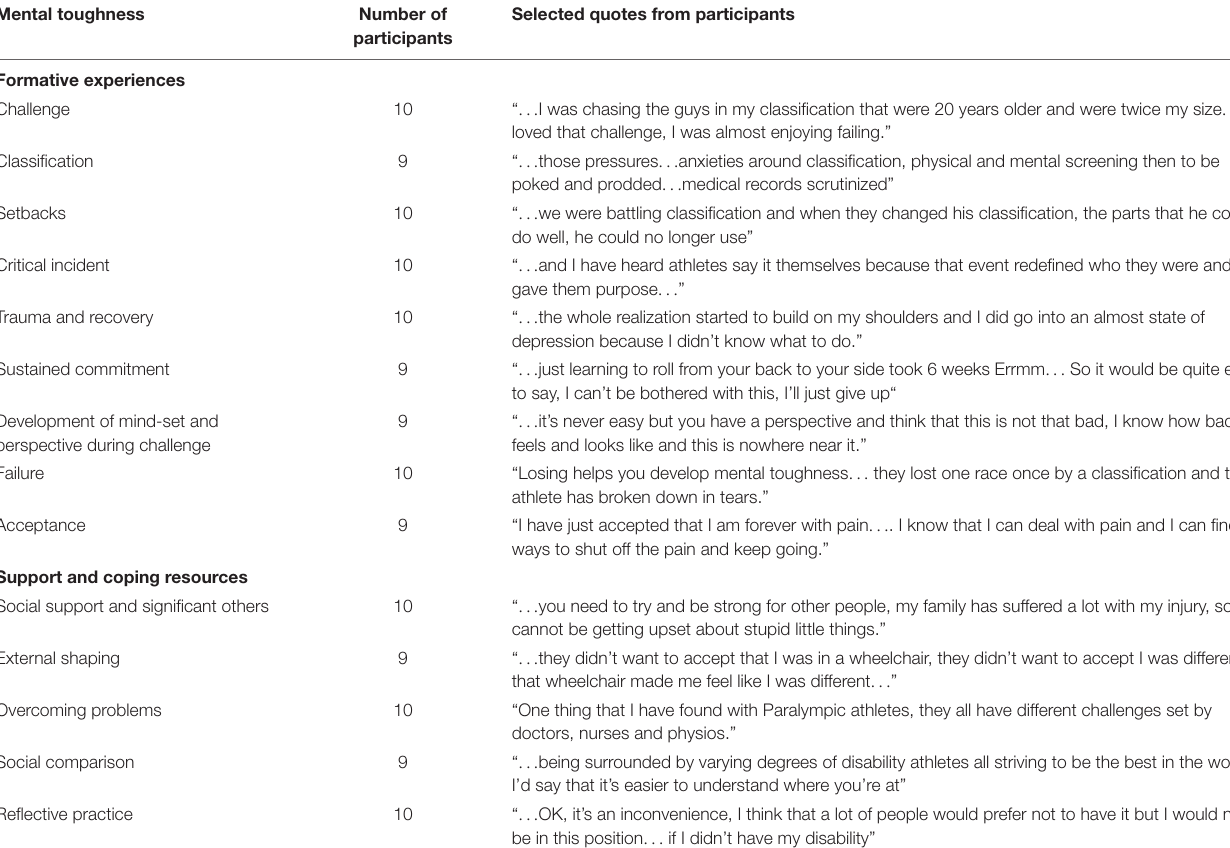
TABLE 2 | Summary of themes and examples of raw data extracts for MT development in Paralympians. Mental toughness Number of Selected quotes from participants